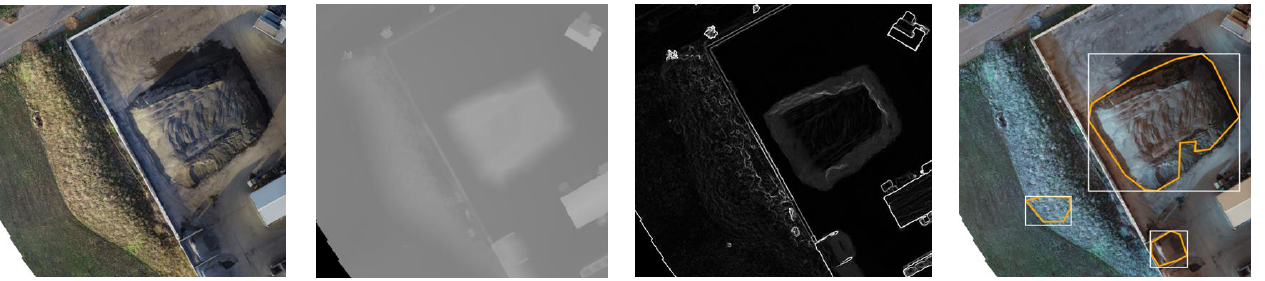
Figure 22 . Selected area from test site A as an example for the ability to distinguish between bulk material heaps and hills that are part of the landscape.